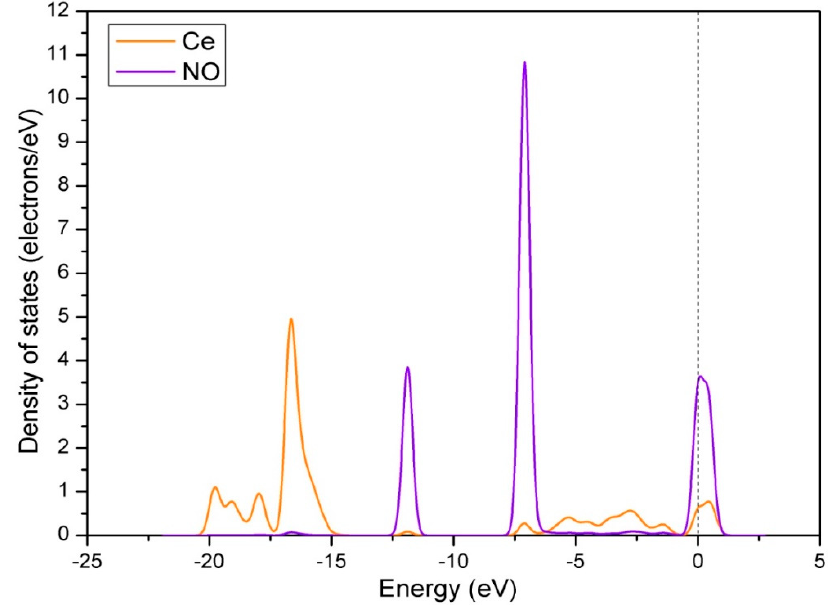
Figure 11. Density of states of adsorbed NO molecule and Ce atom when NO is adsorbed on the Ce-doped LaO-terminated LaCoO 3 (011) surface with hollow-NO configuration.